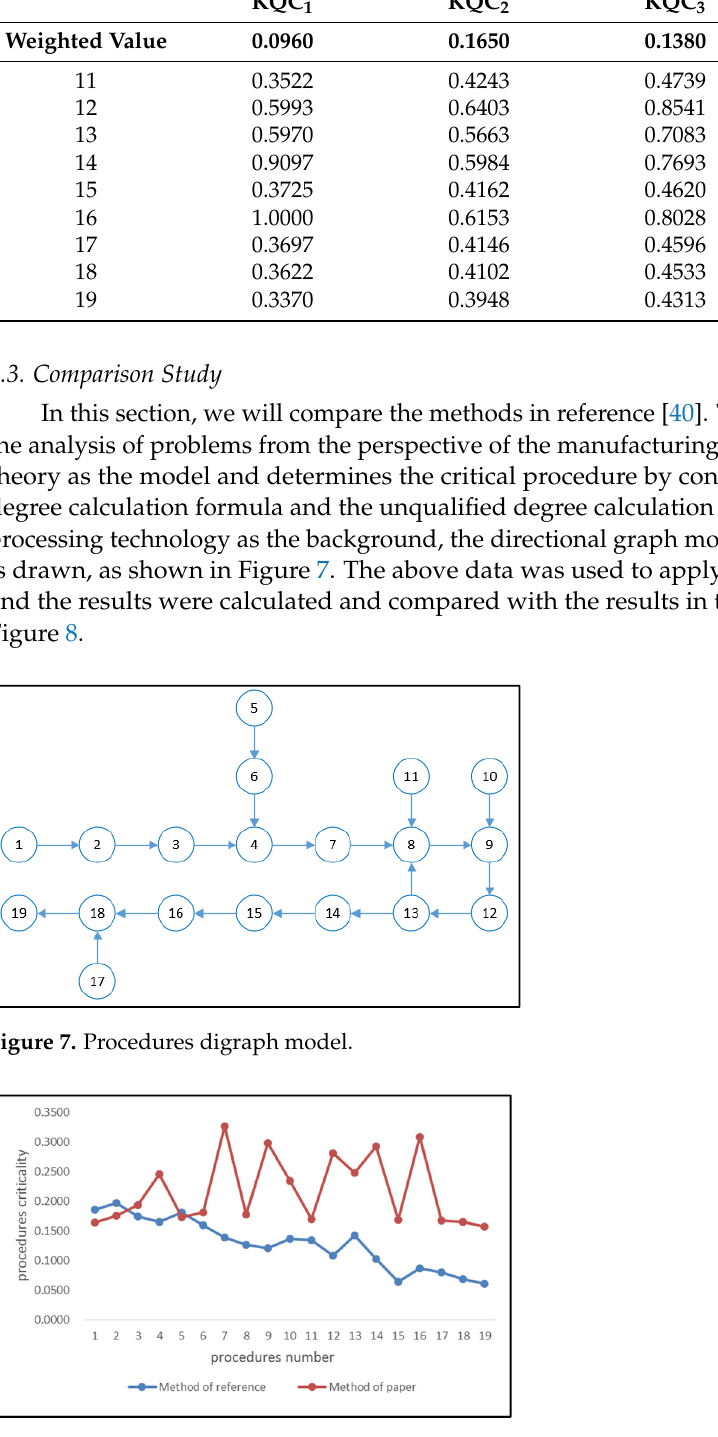
Figure 8. A comparison of the two